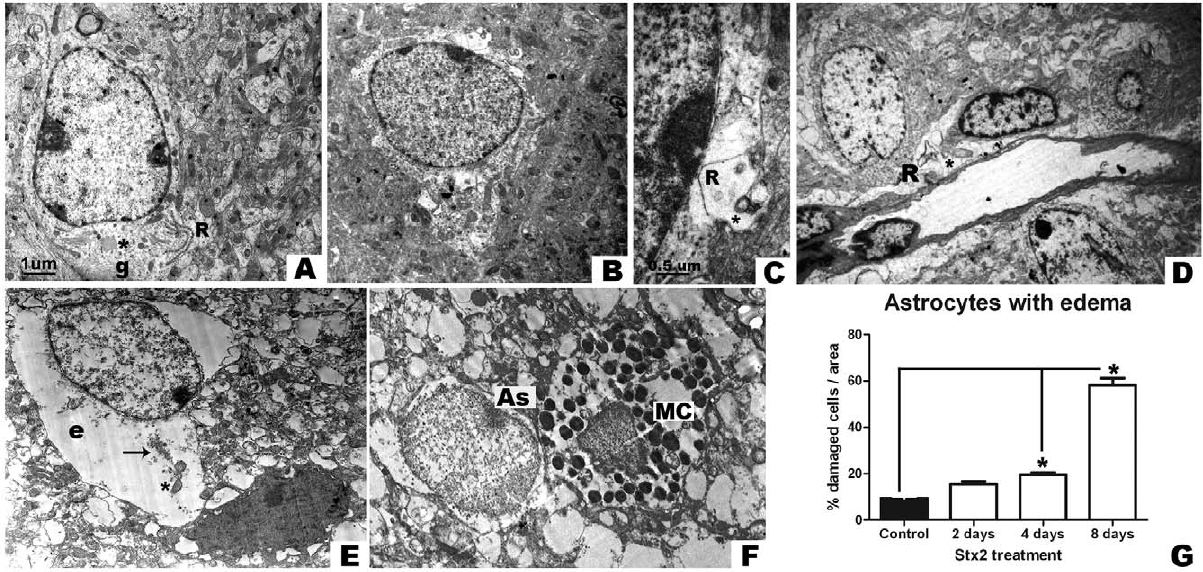
Figure 3. Intravenous administration of Stx2 causes astrocytic edema and mast cell extravasation. Electron micrograph showing a conserved astrocyte after i.v. vehicle administration (A); conserved mitochondria (*), endoplasmic reticulum (R) and gliofilaments (g). After 2 days: astrocytes show significant cytoplasmic edema (B); disorganized endoplasmic reticulum (R) and swollen mitochondria (*) (C). After 4 days: evident astrocytic edema along the perivasculature (D); disorganized endoplasmic reticulum (R) and swollen mitochondria (*) with disorganized inner membranes. After 8 days: altered astrocyte showing watery cytoplasmic edema (e), disorganized rough endoplasmic reticulum (arrow) and mitochondria with broken membranes (*) (E); a neighboring conserved oligodendrocyte can be observed. Extravasation of a mast cell (observable granules, MC) in contact with an astrocyte (As) (F). Quantification of the percentage of damaged astrocytes showing edema (G). Significant results are observed starting on day 4. The maximum number of astrocytes with edema in Stx2-treated mice is observed on day 8 (*). Results are expressed as a percentage of the total number of astrocytes in an area of 3721 m m 2 . Data are mean 6 SEM of 6–8 experiments (G). An asterisk denotes statistical significance, p , 0.05. The scale bar in A applies to A, B, and D–F electron